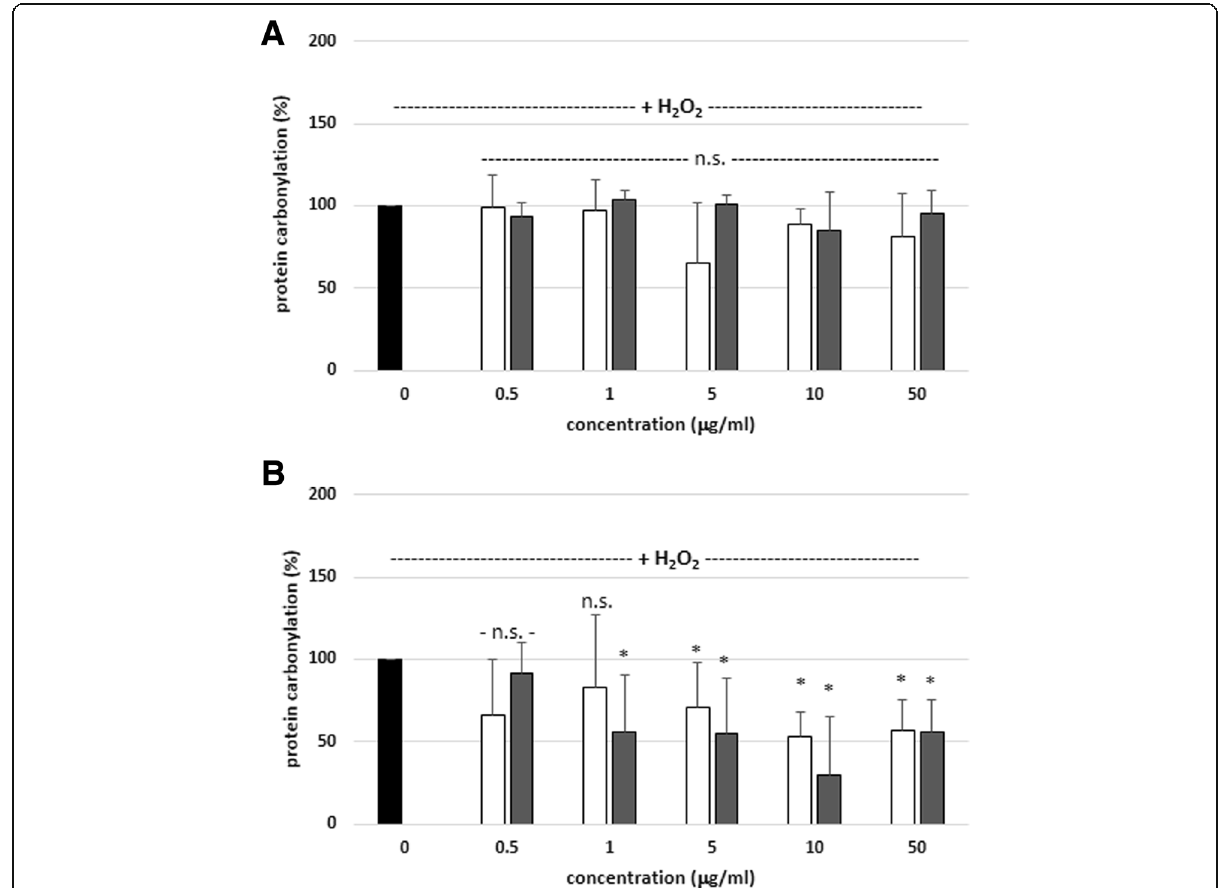
Fig. 3 Effects of SBT twig and leaf extracts (0.5 – 50 μ g/mL; 15 min ( a ) and 60 min ( b )) on plasma protein carbonylation induced by H 2 O 2 . In these experiments the carbonyl group level (marker of protein oxidation) in control samples (plasma treated only with H 2 O 2 ) was 17.1 ± 4.3 nmol/mg of plasma protein. Data represent means ± SD of 6 – 12. The effect of five different concentrations of two tested extracts (0.5, 1, 5, 10 and 50 μ g/mL; for 15 min) was not statistically significant ( p > 0.05 (n.s.)) in comparison to control. The effect of two different concentrations of SBT twig extracts (0.5 and 1 μ g/mL; for 60 min) was not statistically significant ( p > 0.05 (n.s.)) in comparison to control. The effect of one concentration of SBT leaf extract (0.5 μ g/mL; for 60 min) was not statistically significant ( p > 0.05 (n.s.)) in comparison to control. The effect of three different concentrations of SBT twig extracts (5, 10 and 50 μ g/mL; for 60 min) was statistically significant (* p < 0.05), in comparison to control. The effect of four different concentrations of SBT leaf extracts (1, 5, 10 and 50 μ g/mL; for 60 min) was statistically significant (* p < 0.05), in comparison to control. The effects were not statistically significant: SBT twig extract-treated plasma vs. SBT leaf extract-treated plasma (for 15 and 60 min, p > 0.05 (n.s.); for all tested concentrations- 0.5 - 50 μ g/mL). black diagram – control, white diagram – twig, grey diagram -